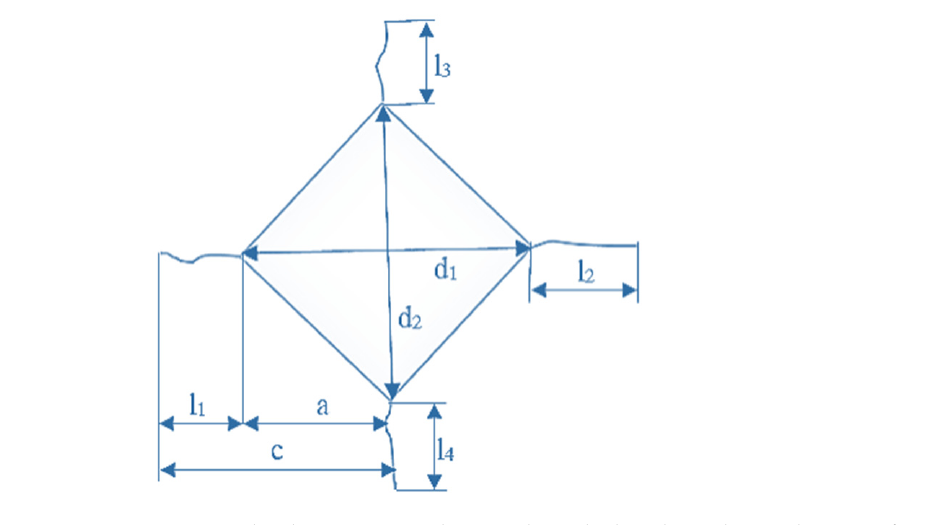
Table 5. All experimental values used for response surface plots and regression